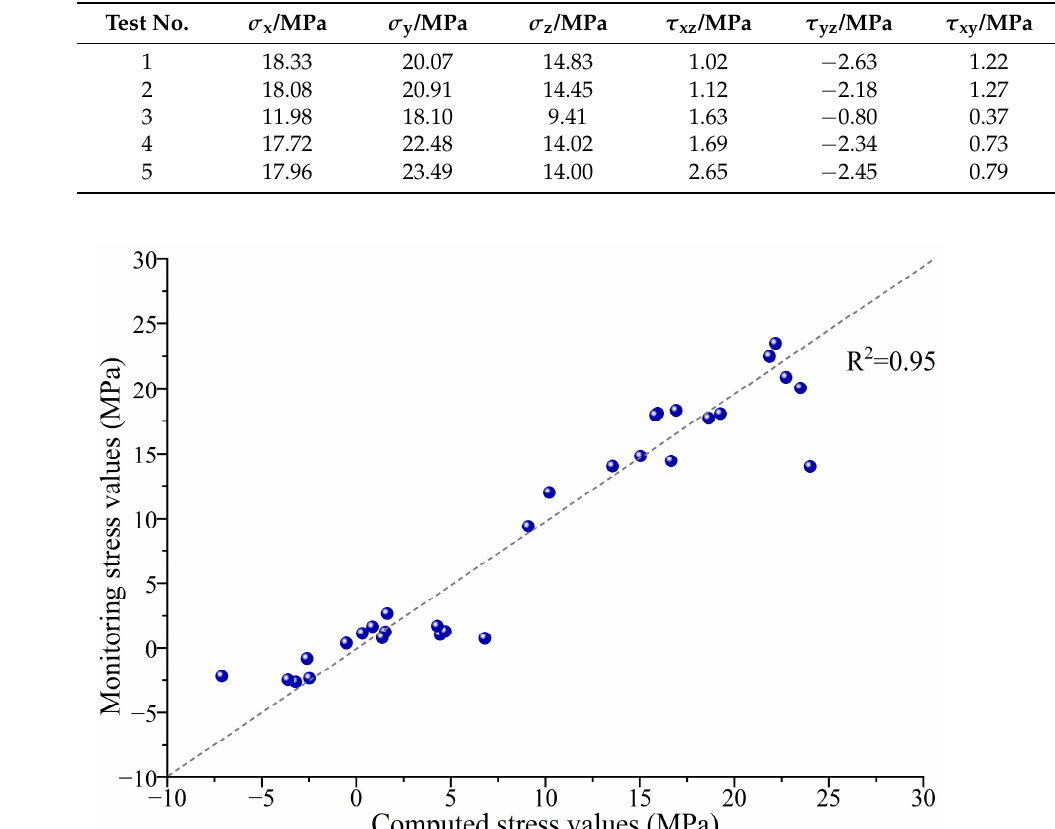
Figure 7. Stress distribution in the cross-section of the main powerhouse. ( a ) the first principal stress, ( b ) the third principal stress.